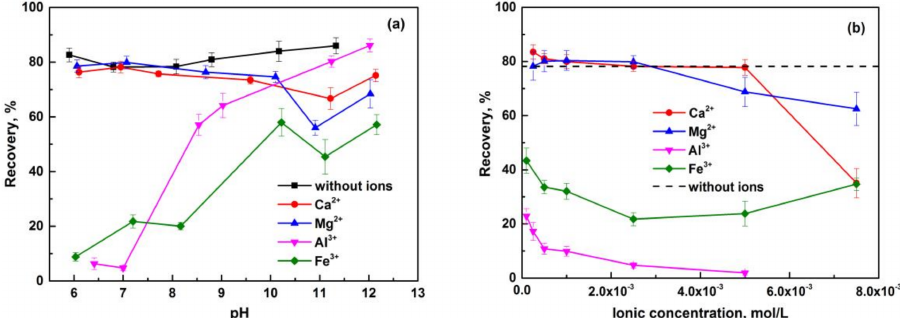
Figure 3. ( a ) Effect of pH on the floatability of dolomite in the presence of metal ions at a concentration of 2.5 × 10 − 3 M; ( b ) Effect of ionic concentration on the floatability of dolomite at neutral